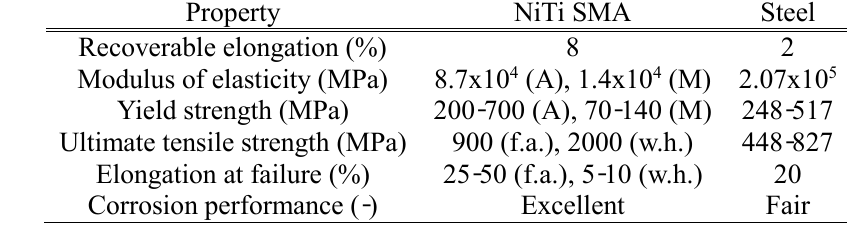
Comparison of the mechanical properties of SMAs and Structural